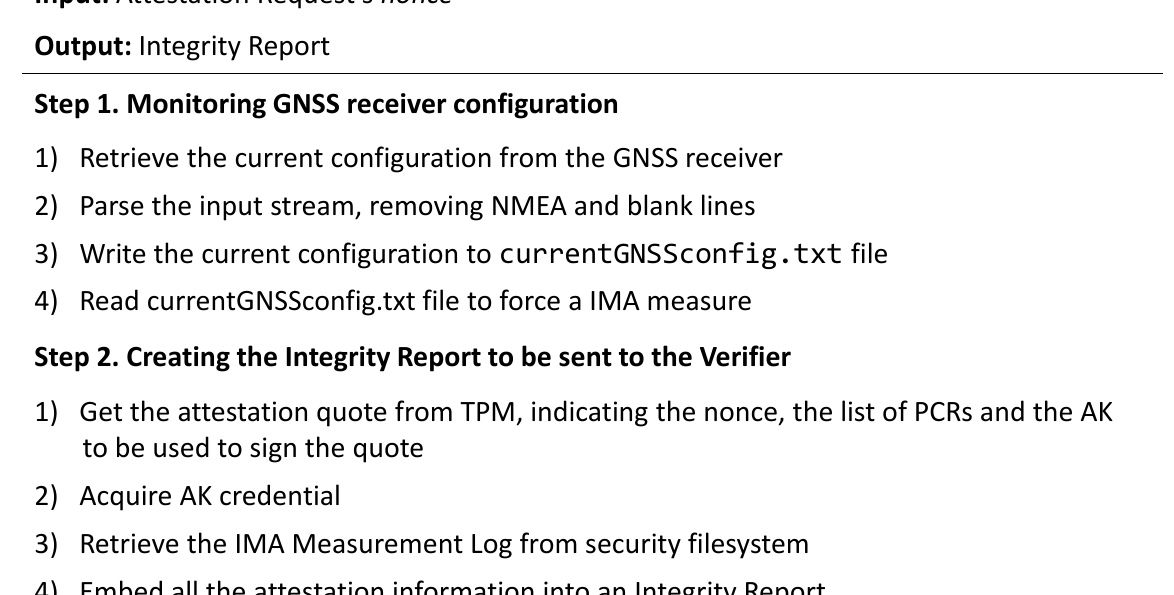
Figure 7. Algorithm steps of the Master Clock